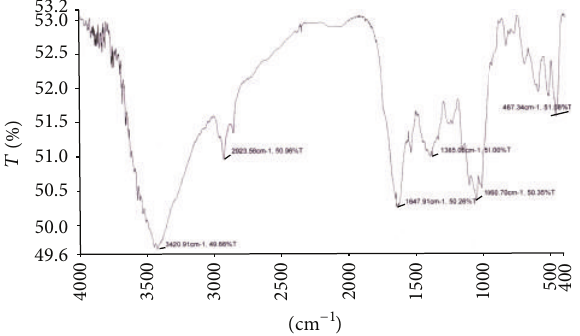
Figure 6: FTIR spectra of control biomass showing different functional groups. The “ 𝑥 ” axis of the spectra denotes wavenumber (cm −1 ) and “ 𝑦 ” axis denotes transmittance (% 𝑇 ).